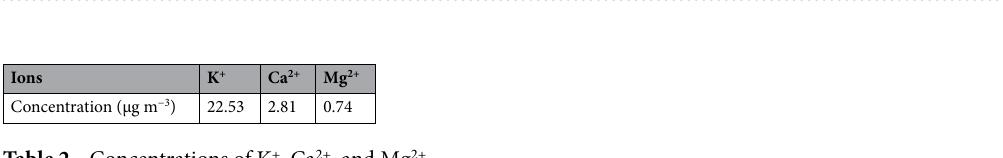
Figure 2. Diurnal variations of α-dicarbonyls, keto-carboxylic acids, and dicarboxylic acids.